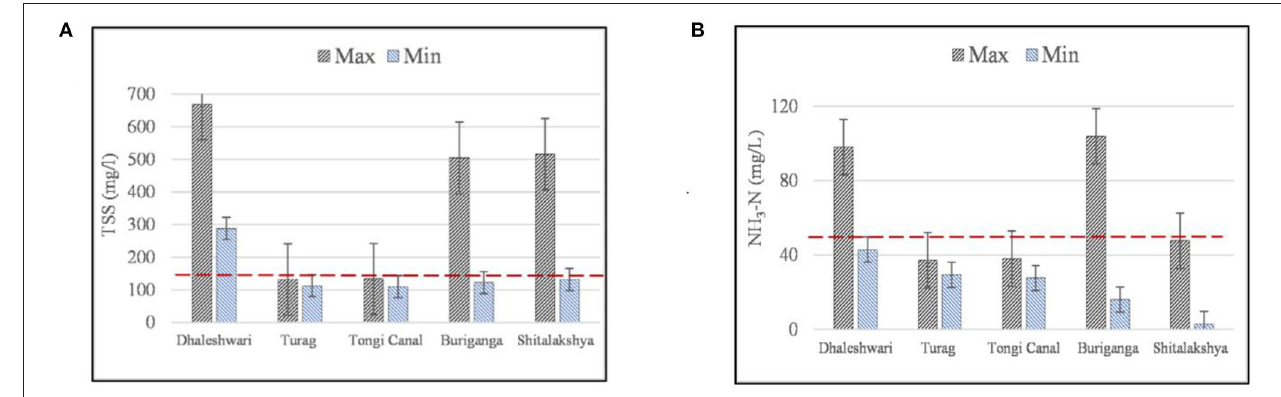
FIGURE 4 | (A,B) Maximum and minimum concentrations of TSS and NH 3 for the selected outfalls along the peripheral rivers of Dhaka (error bars indicate standard error of mean and red dotted lines indicate the Bangladesh standards of water quality according to